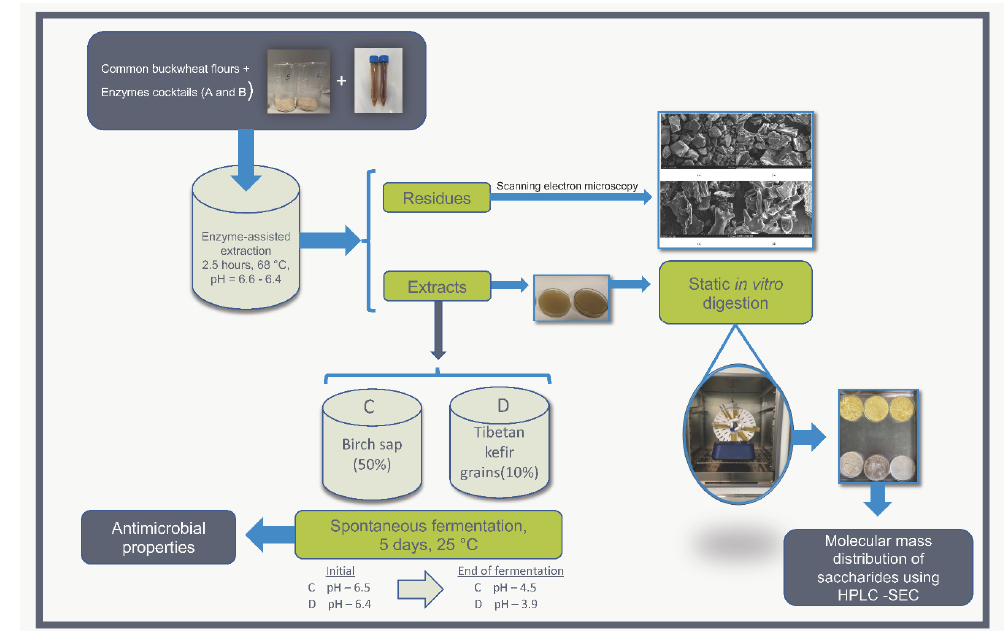
Figure 1. Experimental design